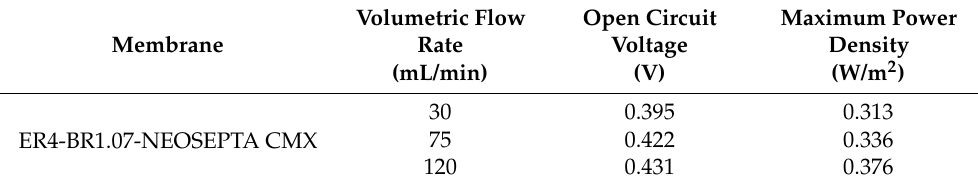
Table 8. RED performance of the synthesized